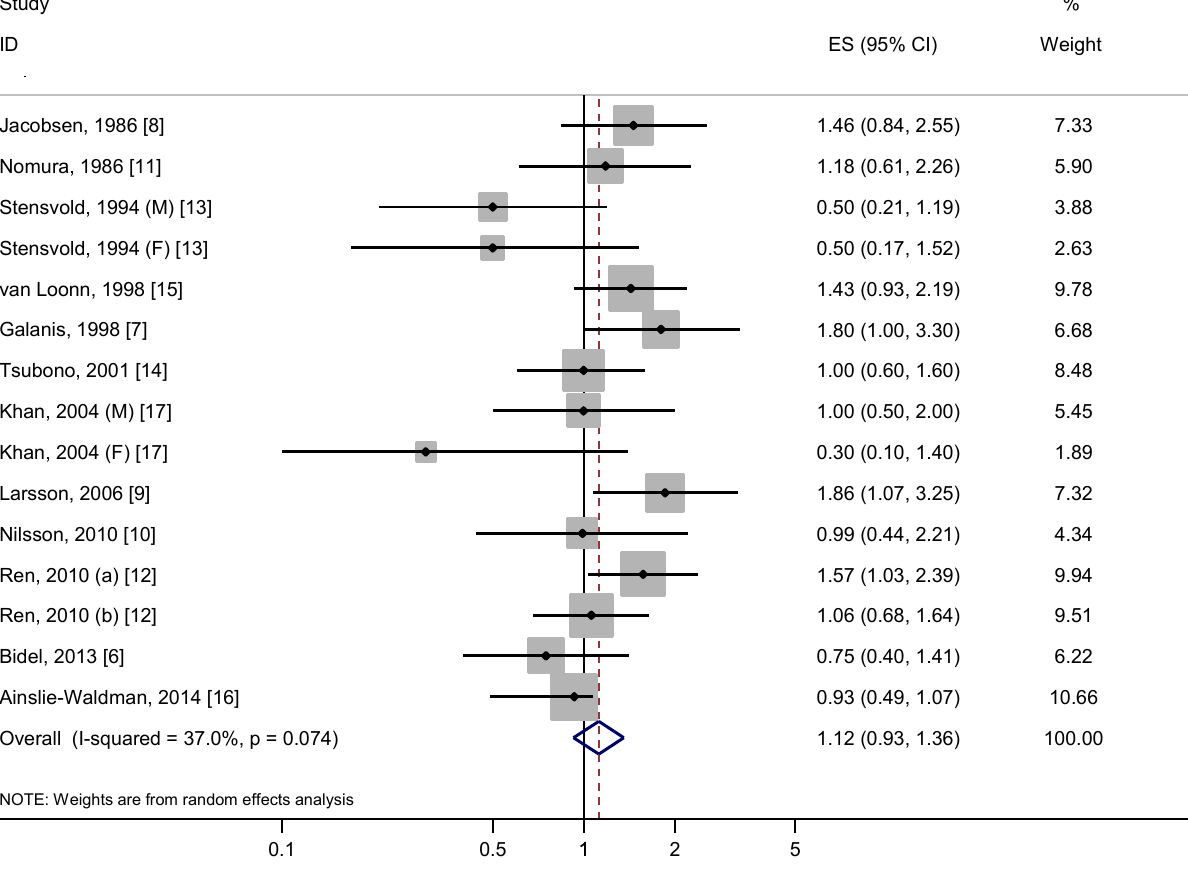
Figure 2. Relative risk of gastric cancer for the highest compared with the lowest categories of coffee consumption. (a) results for gastric cardia cancer; (b) results for gastric non-cardia cancer; M, male; F, female; RR, relative risk; CI, confidence